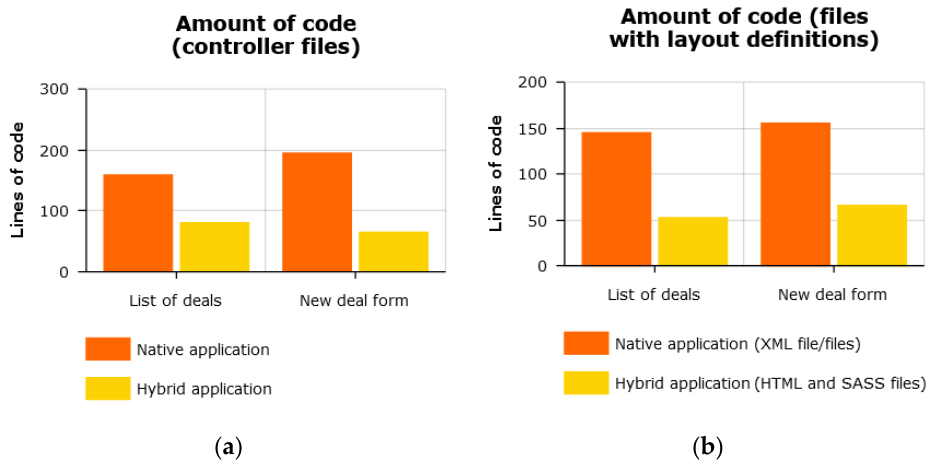
Figure 5. Amount of source code in: ( a ) controller files; ( b ) files with layout definitions.